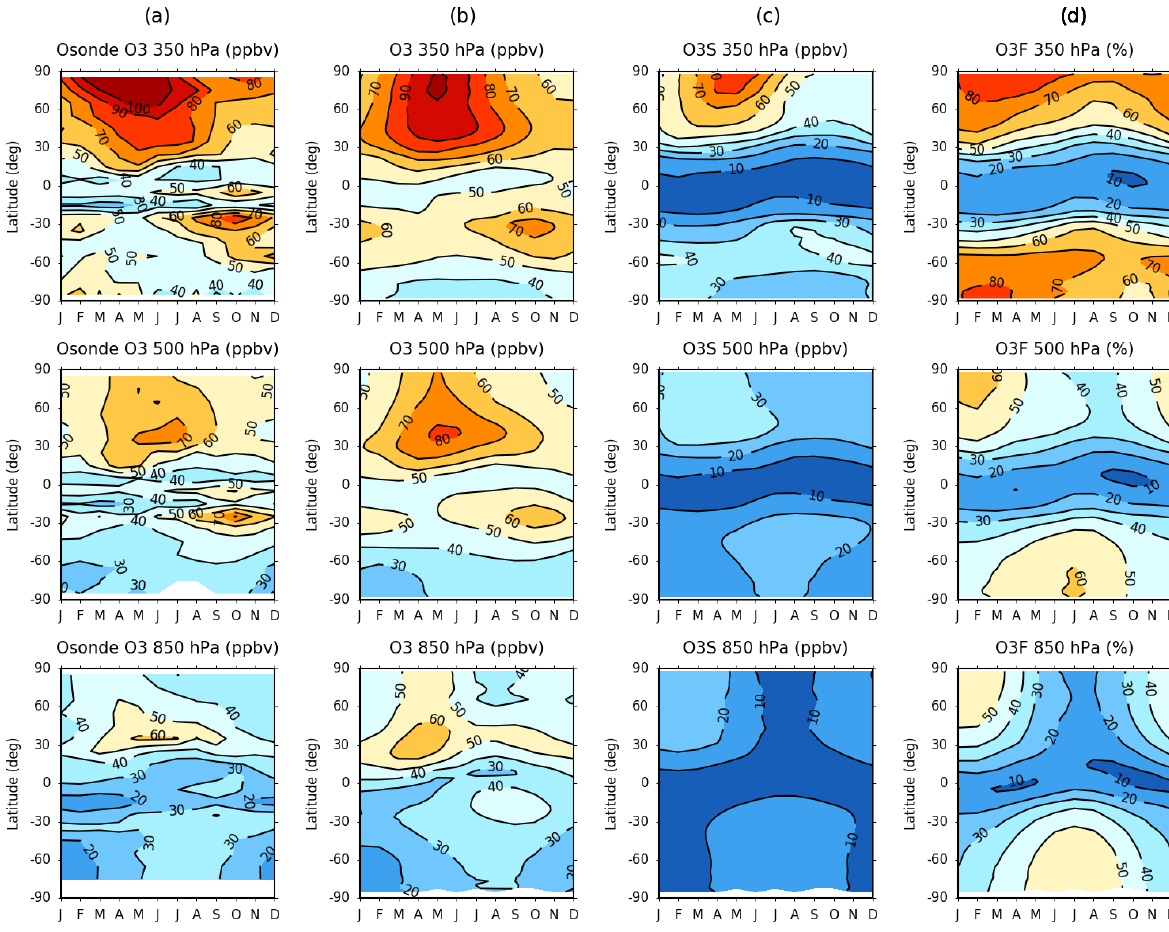
Figure 7. Zonal-mean monthly mean evolution of O 3 VMR (ppbv) derived from (a) ozone-sondes and (b) EMAC O 3 model tracer. The evolution of the (c) EMAC stratospheric O 3 S tracer and (d) O 3 F stratospheric fraction (%) are additionally included over the period 1980– 2010 for 350hPa (top row), 500hPa (middle row) and 850hPa (bottom